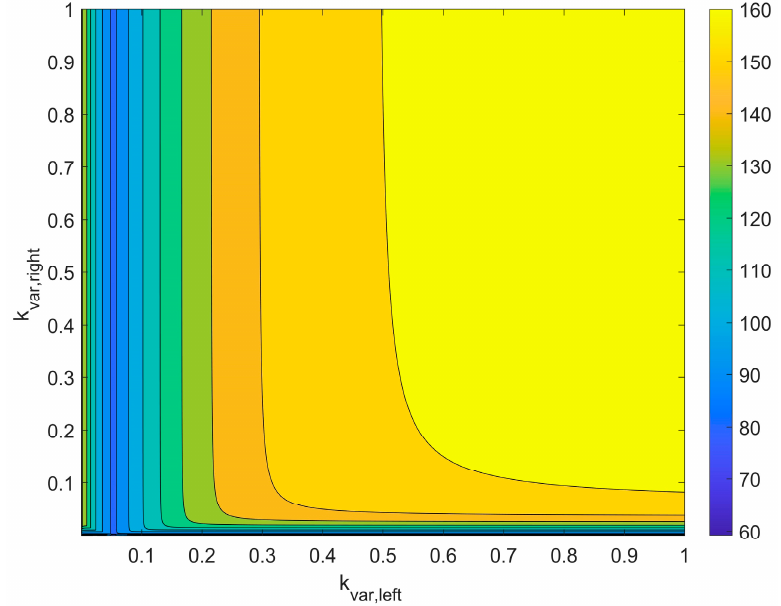
Figure 14. Objective function for a variation of k var , left and k var , right in the range between 0 and 1.